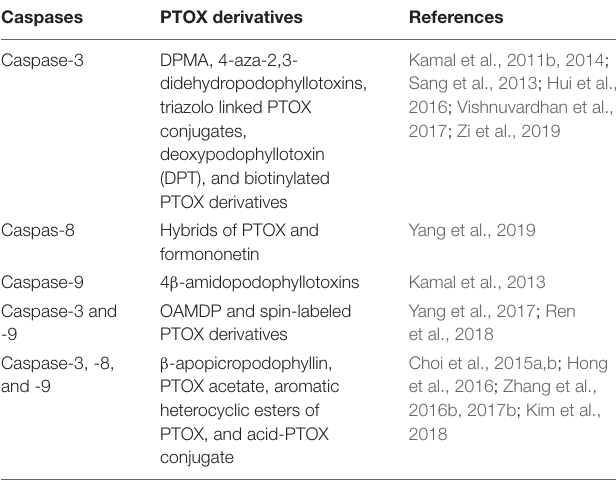
TABLE 2 | Involved caspases in PTOX derivatives